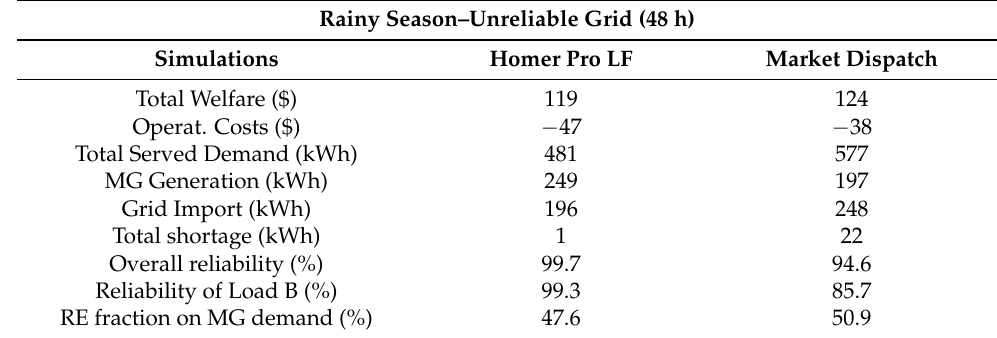
Table 4. Comparison table for simulation results under rainy season with an unreliable main grid. Rainy Season–Unreliable Grid (48 h) Simulations Homer Pro